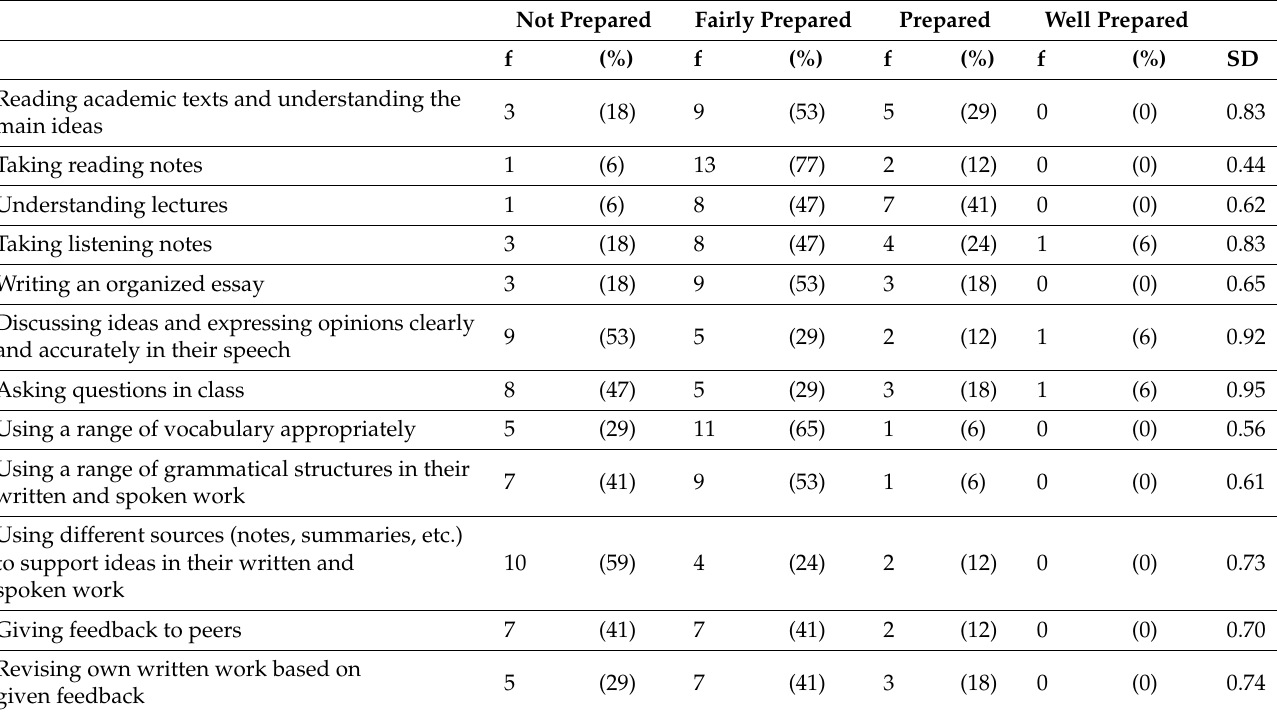
Table 2. Summary of teacher perceptions towards how well PEP prepares students (N = 17).